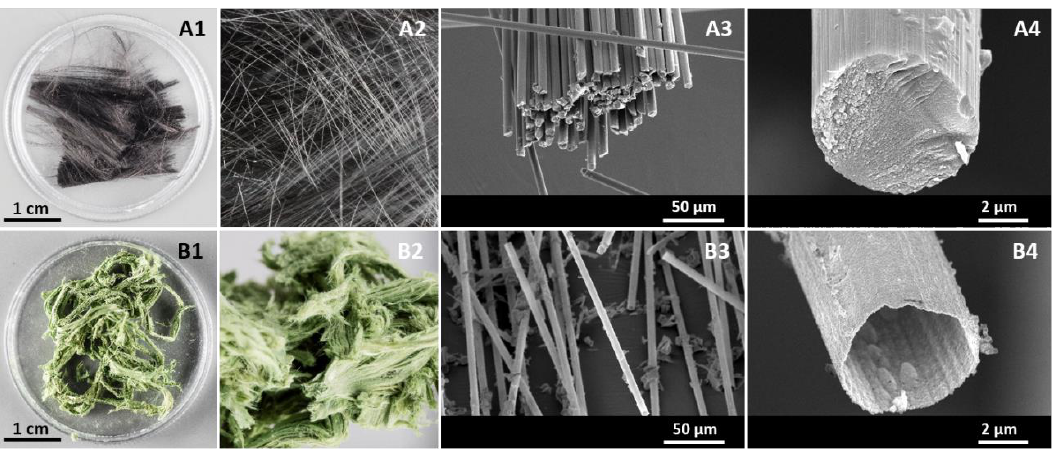
Figure 3. Photographs (1–2) and SEM views (3–4) of the ( A ) carbon fiber template and ( B ) as-templated Cr 2 O 3 material.